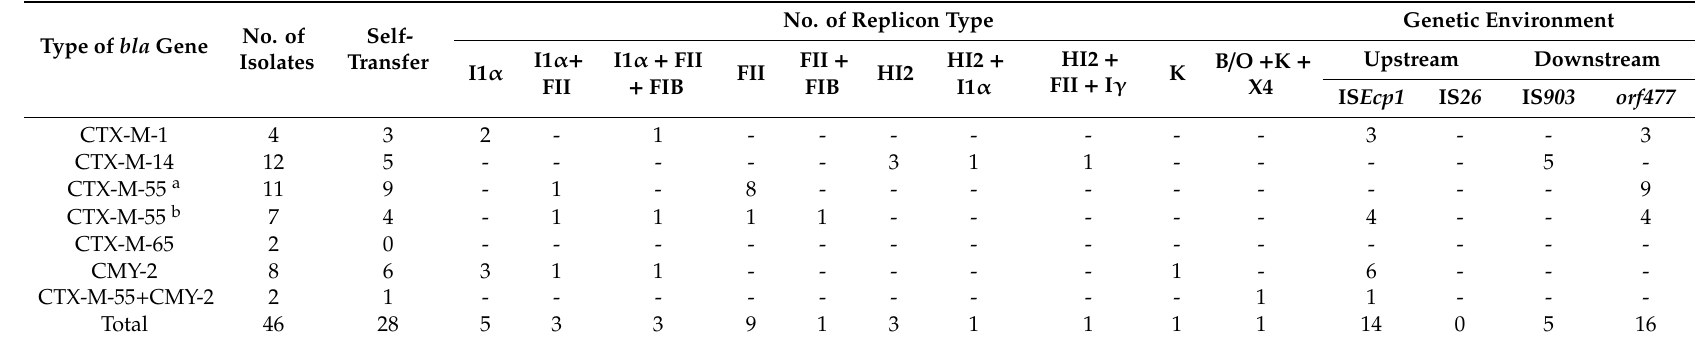
Table 5. Plasmid replicon types and genetic environments of ESBL / pAmpC gene-carrying E. coli transconjugants. Type of bla